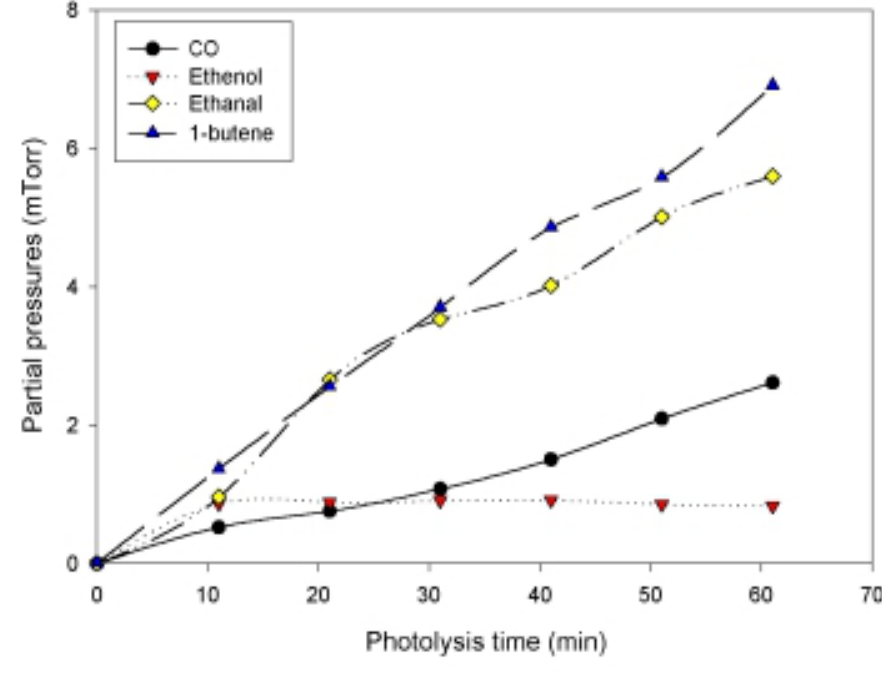
Figure 2. Photolysis of n -hexanal: time profile - variation of the concentrations of products. The CO curve shows that it is not only the primary product, but also a product of the reactions following primary step. Ethenol partial pressure reaches maximum and then starts to decrease by conversion to ethanal, which is in good agreement with simulation of the